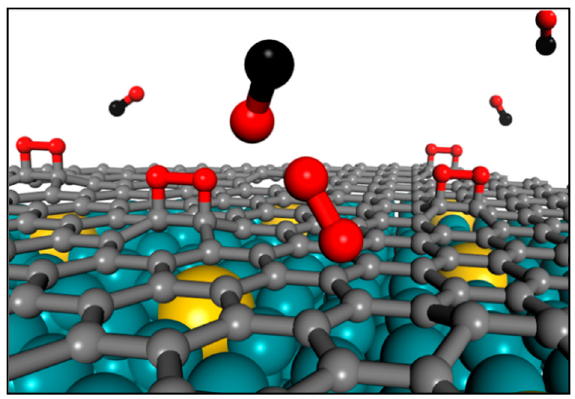
Figure 9. Graphene itself as a catalyst: Activating graphene by engineering the underlying substrate.